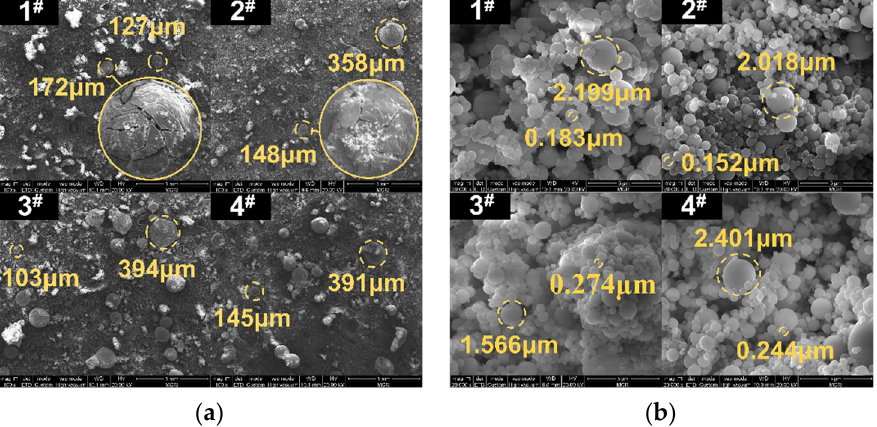
Figure 5. SEM images of CCPs at magnifications of ( a ) 100× and ( b ) 20,000×.